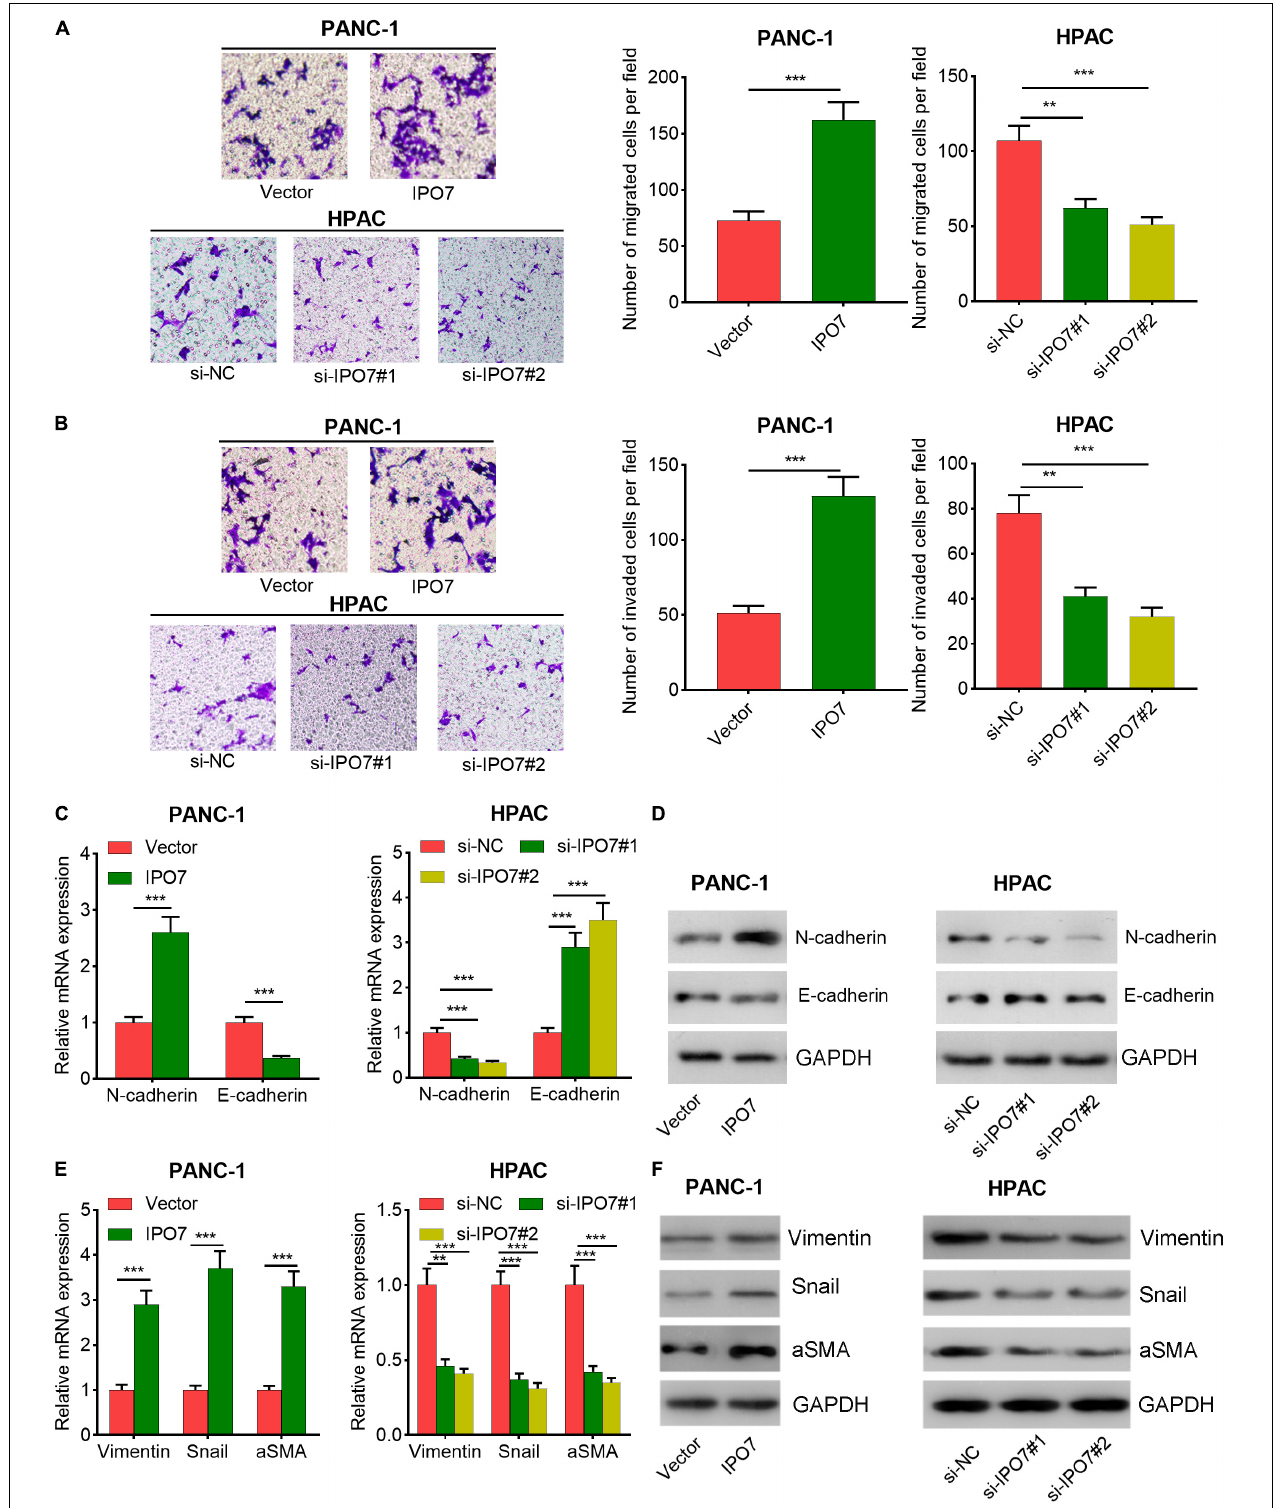
FIGURE 4 | Importin 7 (IPO7) regulates pancreatic cancer cell migration and invasion. (A,B) The migration and invasion of pancreatic cancer cells were assessed by Transwell assay. (C–F) qPCR and Western blot were performed to determine the expression of epithelial–mesenchymal transition (EMT)-related indicators, including E-cadherin, N-cadherin, vimentin, Snail, and alpha-smooth muscle actin (aSMA). ** p < 0.01, *** p < 0.001.